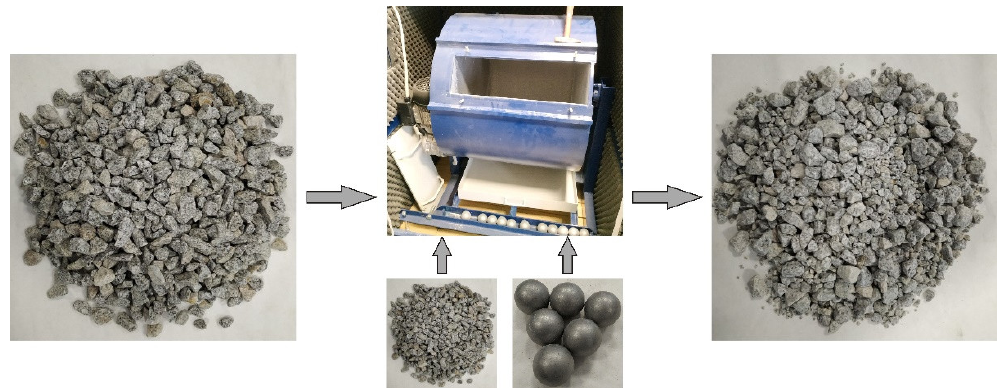
Figure 2. The LA test procedure.